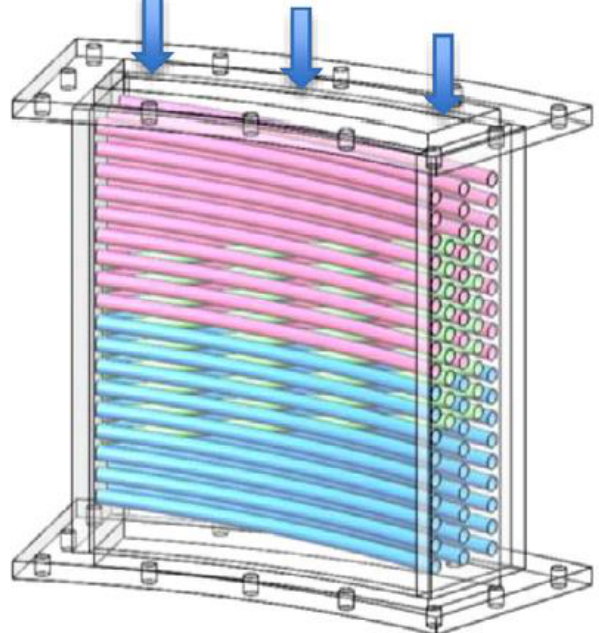
Figure 1. Experimental model of helical tube array